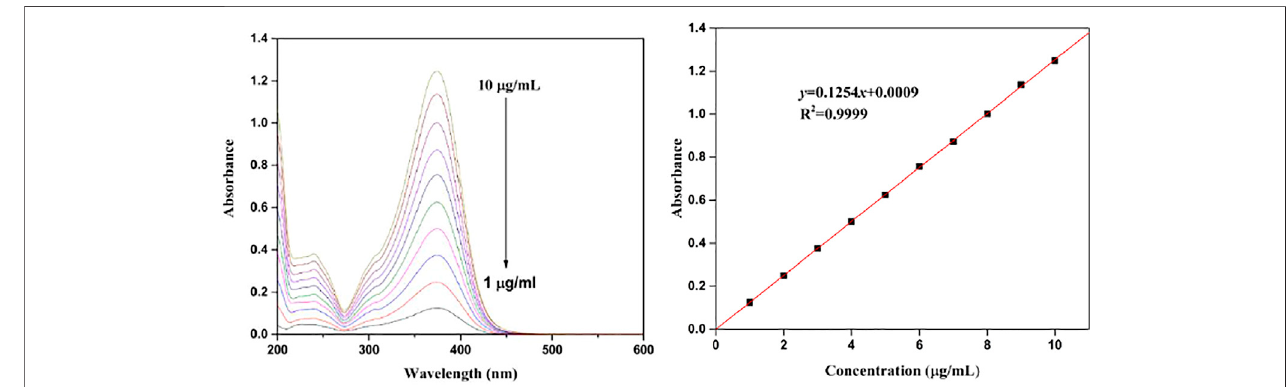
FIGURE 4 | Concentration – absorbance calibration curve of